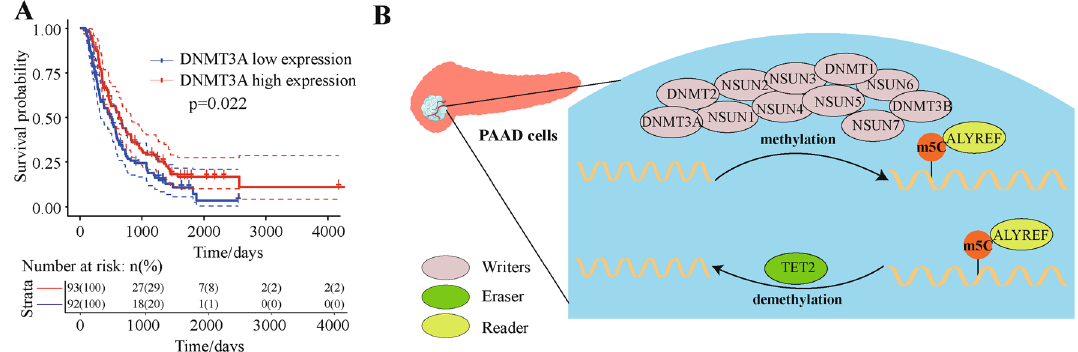
Figure 6. Relationship between DNMT3A expression and patient prognosis using validation data set. Analysis of patients from validation dataset ICGC-PACA-CA. ( A ) Relationship between DNMT3A expression and patient prognosis in the validation dataset ( P = 0.022). ( B ) Mechanisms of m5C methylation regulation in